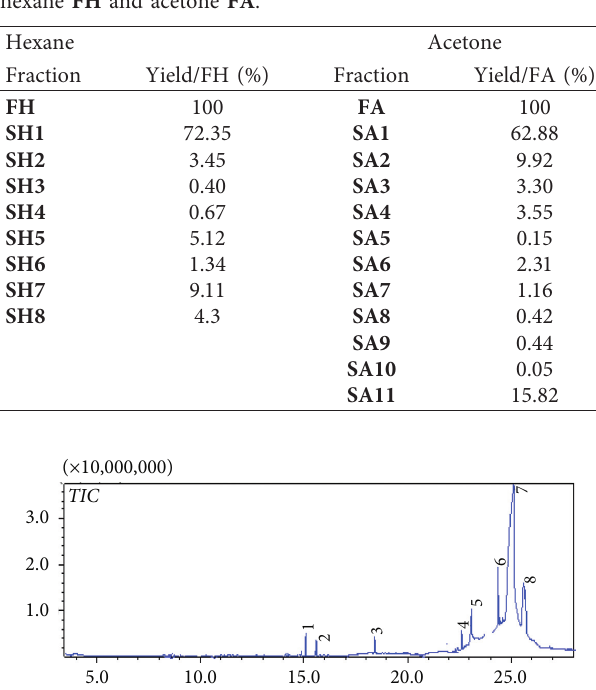
Table 1: Yields of fractions derived from the mother extracts of hexane FH and acetone FA .